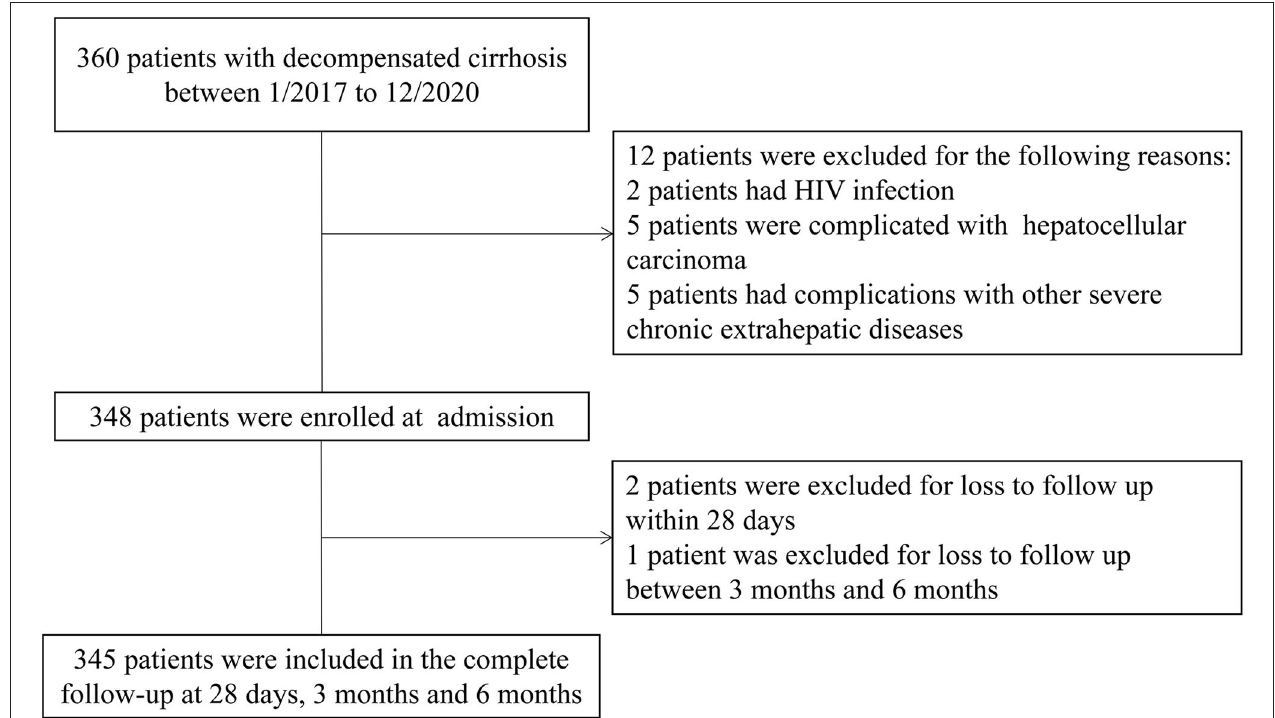
FIGURE 1 | The flowchart in the